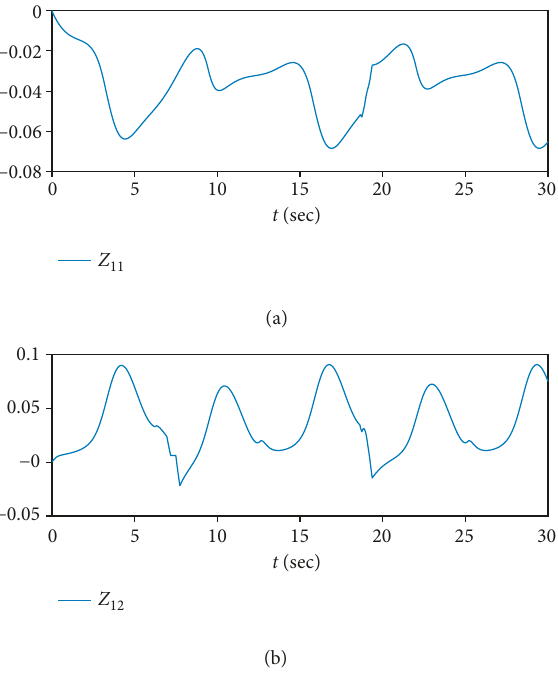
Figure 3: The time response of tracking error z